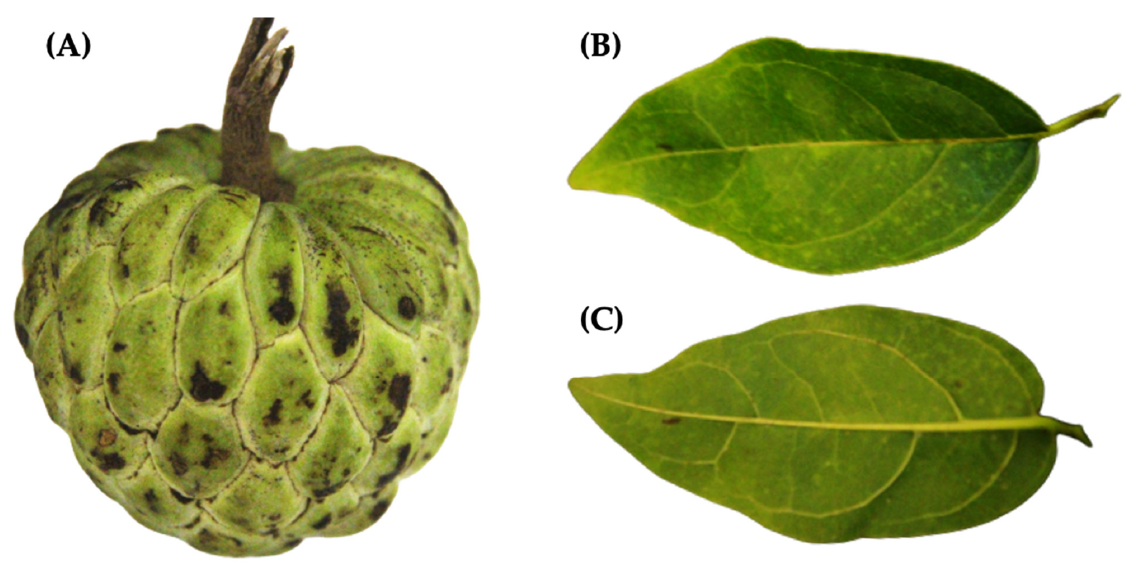
Figure 1. ( A ) Annona squamosa L. fruit and leaves. ( B ) Dorsal view of Annona squamosa L. leaves. ( C ) Ventral view of A. squamosa L. leaves.